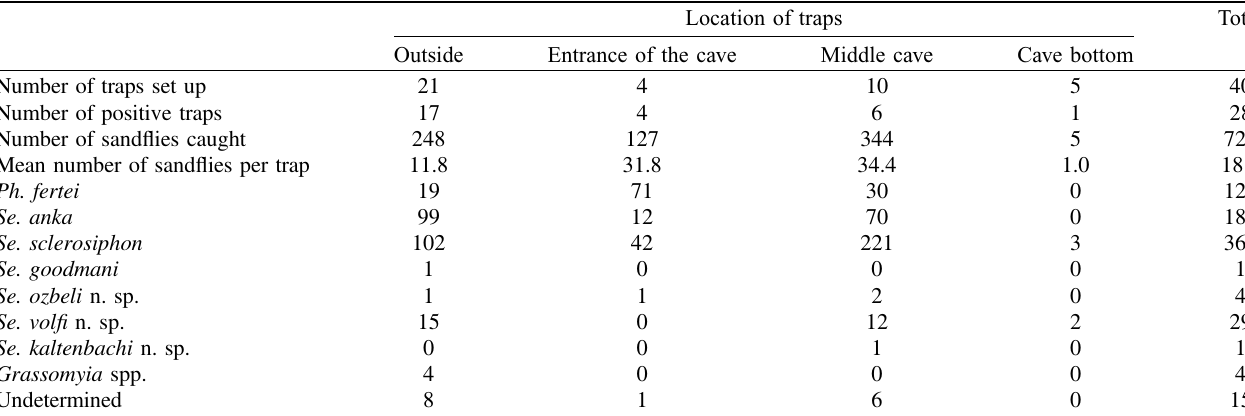
Table 2. Summary of sand fl ies collection in the Ankarana tsingy in relation with trap position.